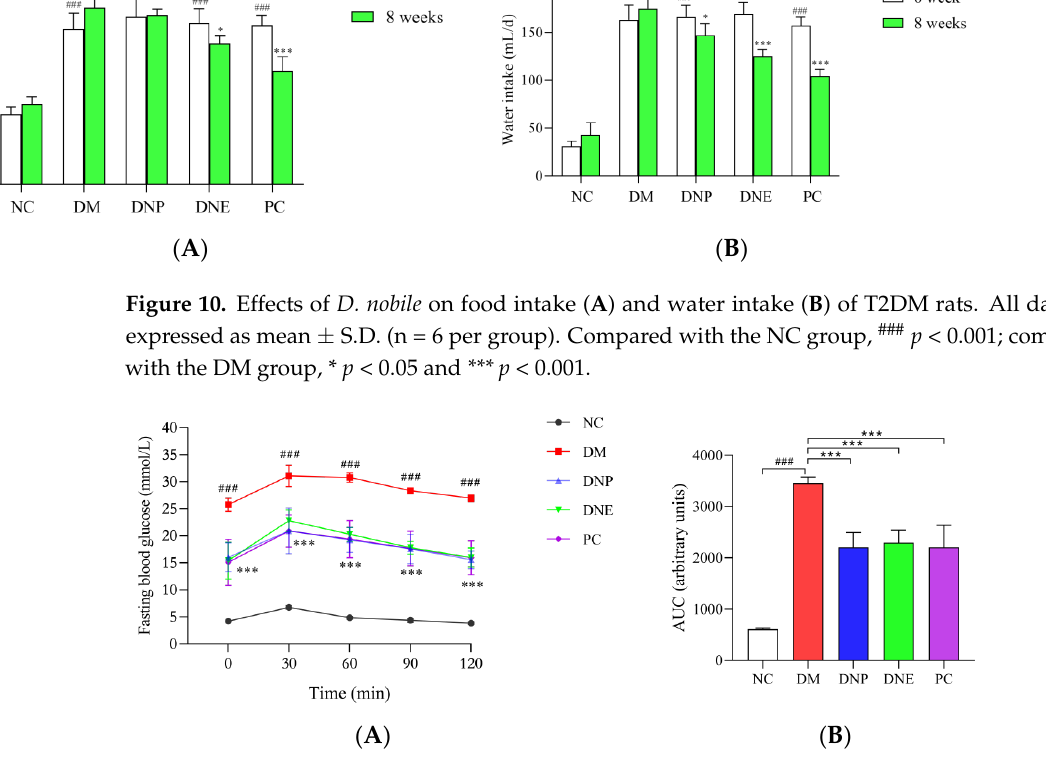
Figure 10. Effects of D. nobile on food intake ( A ) and water intake ( B ) of T2DM rats. All data are expressed as mean ± S.D. (n = 6 per group). Compared with the NC group, ### p < 0.001; compared with the DM group, * p < 0.05 and *** p < 0.001.